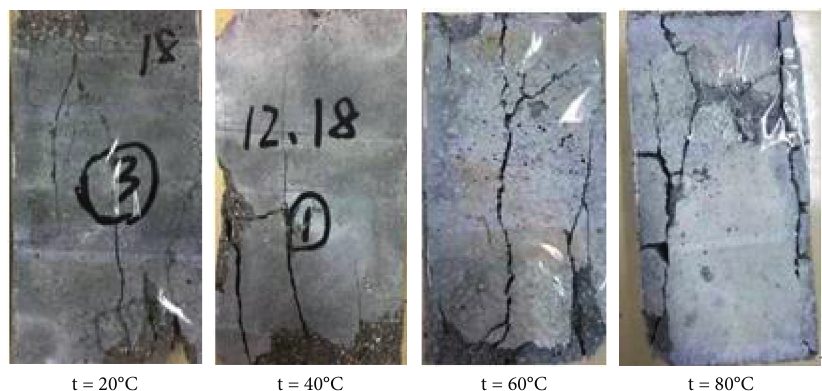
Figure 13: Crack morphology of the rock-like specimen at different temperatures.